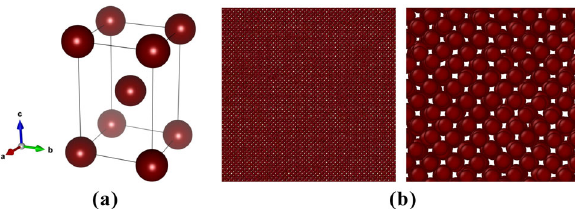
Fig. 3 a Cell structure of In. b Supercell structure and local amplifi- cation diagram after In